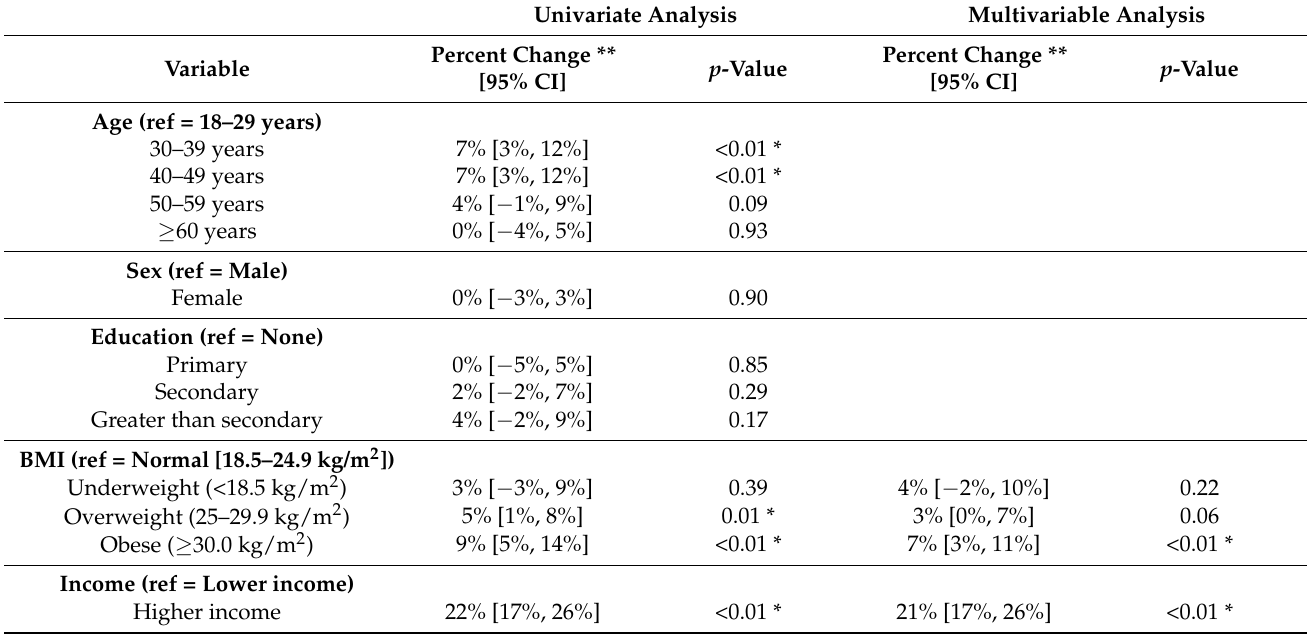
Table 3. Associations between sociodemographic characteristics and servings per week of fruit and vegetable consumption among the study